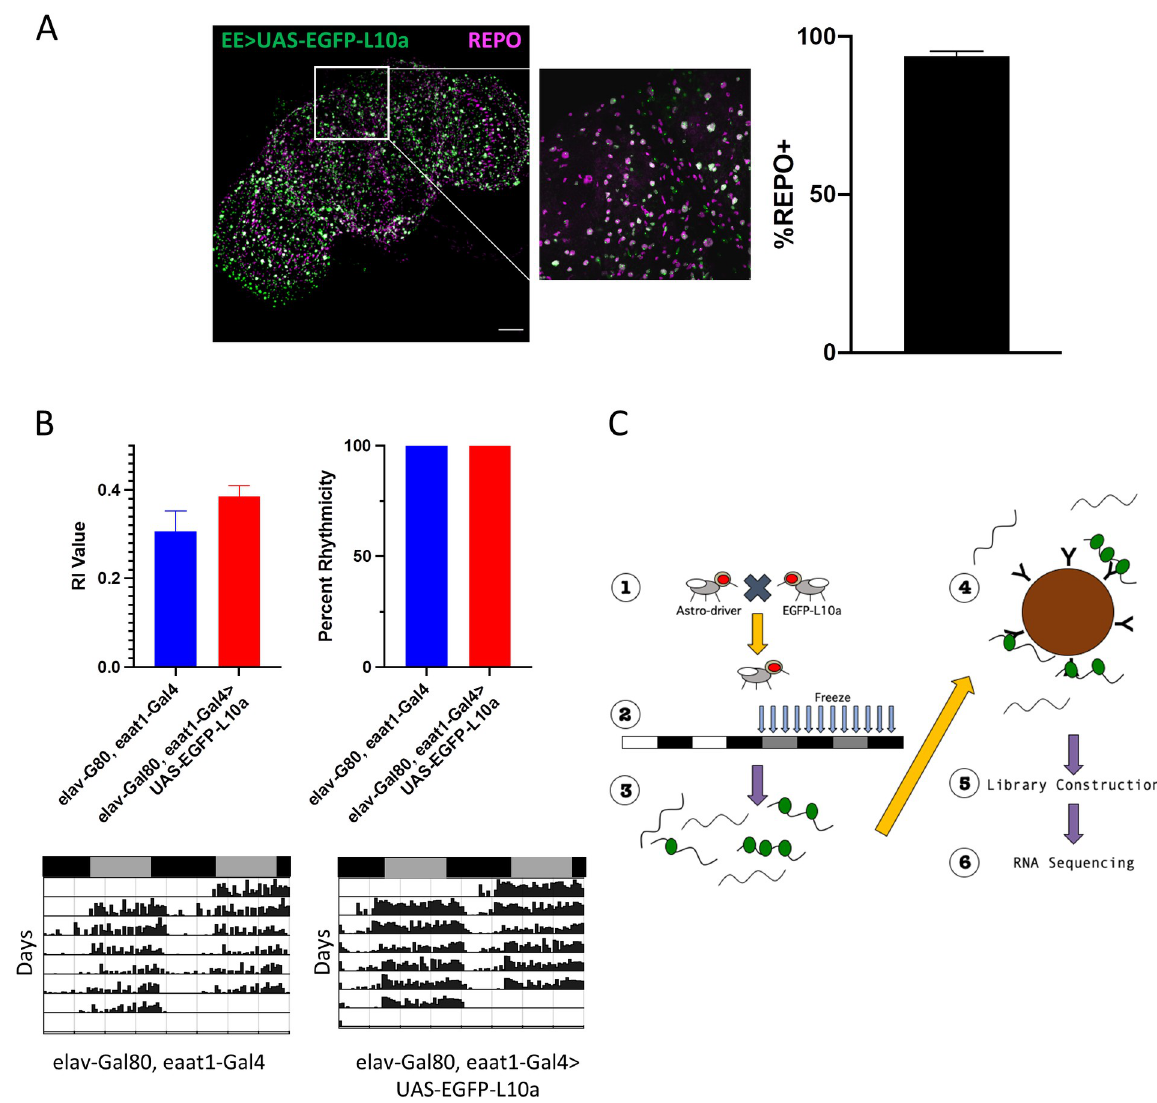
Fig 1. Using TRAP for circadian profiling of fly astrocytes. A) Eaat1-Gal4 with elav-Gal80 (EE) was used to express EGFP-L10a in astrocytes. Brains were also stained with REPO (magenta) to visualize glial cells. Maximum-projection image (left) shows overall distribution of both EGFP-L10a and REPO throughout the brain at 20X magnification. The offset image shows colocalization of EGFP-L10a with REPO at high- magnification (60X). Scale bar = 50 μ m. EGFP-L10a cells were counted for REPO positivity with 93.7% ± 1.7% EGFP-L10a cells positive for REPO (n = 4 brains). B) Representative actograms of DD behavior for data represented in C. Black bars represent night (CT0-11) while gray bars represent day (CT12-23). C) Free-running (DD) behavior data for elav-G80, UAS-EGFP-L10a (blue) and elav-Gal80, eaat1-Gal4 > E2 (red). Expression of EGFP-L10a does not result in decreased circadian rhythmicity. n = 10 flies for each group. D) Flies were crossed to make progeny that expressed EGFP-L10a in astrocytes (1) and then entrained to a 12:12 LD schedule. Flies were flash frozen every four hours across 2 days in DD (2). RNA was extracted (3) and immunoprecipitated (4) using a high-affinity EGFP antibody. RNA was then converted into cDNA libraries (5) and processed for sequencing (6).